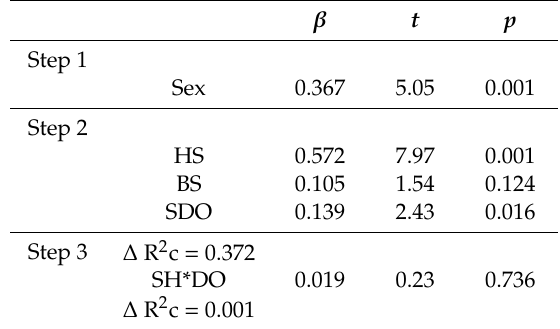
Table 2. Multiple regression analysis on myths of IPVAW (Interpersonal violence against women)